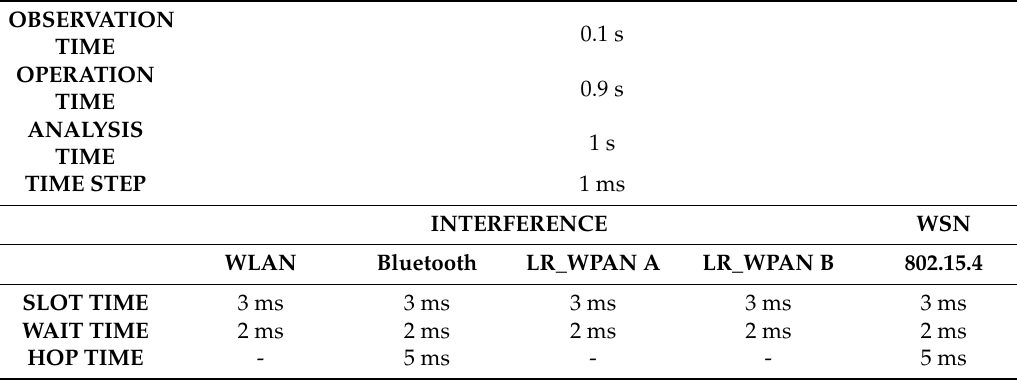
Table 3. Time parameters employed in the analysis.